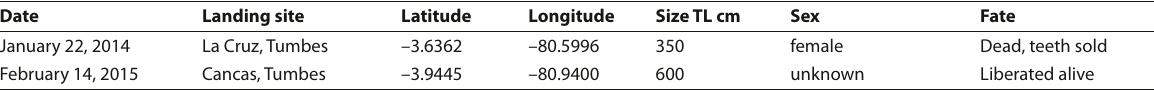
Table 1. New records of Pristis pristis in Peru including capture data and the fate of the individuals.